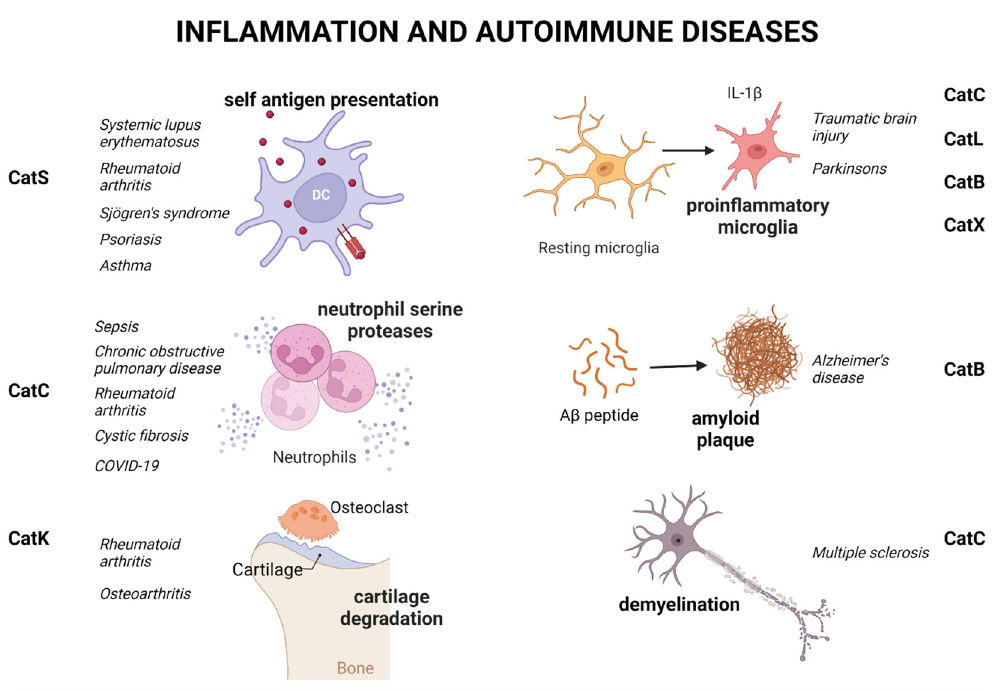
Figure 1. Cysteine cathepsin involvement in inflammation and autoimmune diseases. Cysteine cathepsins are involved in the presentation of self-antigens via MHC II molecules on antigen presenting cells, dysregulation of neutrophil serine proteases, and cartilage degradation. These processes detrimental for several autoimmune diseases. On the other hand, cysteine cathepsins also participate in the generation of inflammation in the brain and therefore impact the progression of several neurodegenerative diseases. Created with Biorender. CatS cleaves the invariant chain p10 (invariant fragment, CD76, Lip10) that